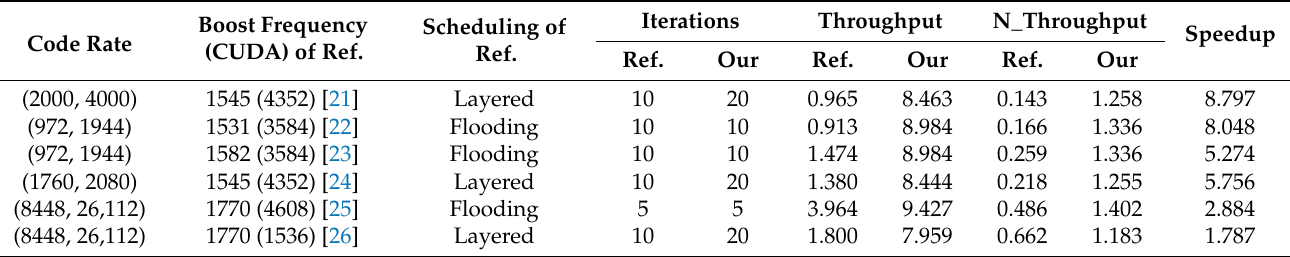
Table 4. Comparison of the throughput performance with other GPGPU-based works. Boost Frequency Code Rate